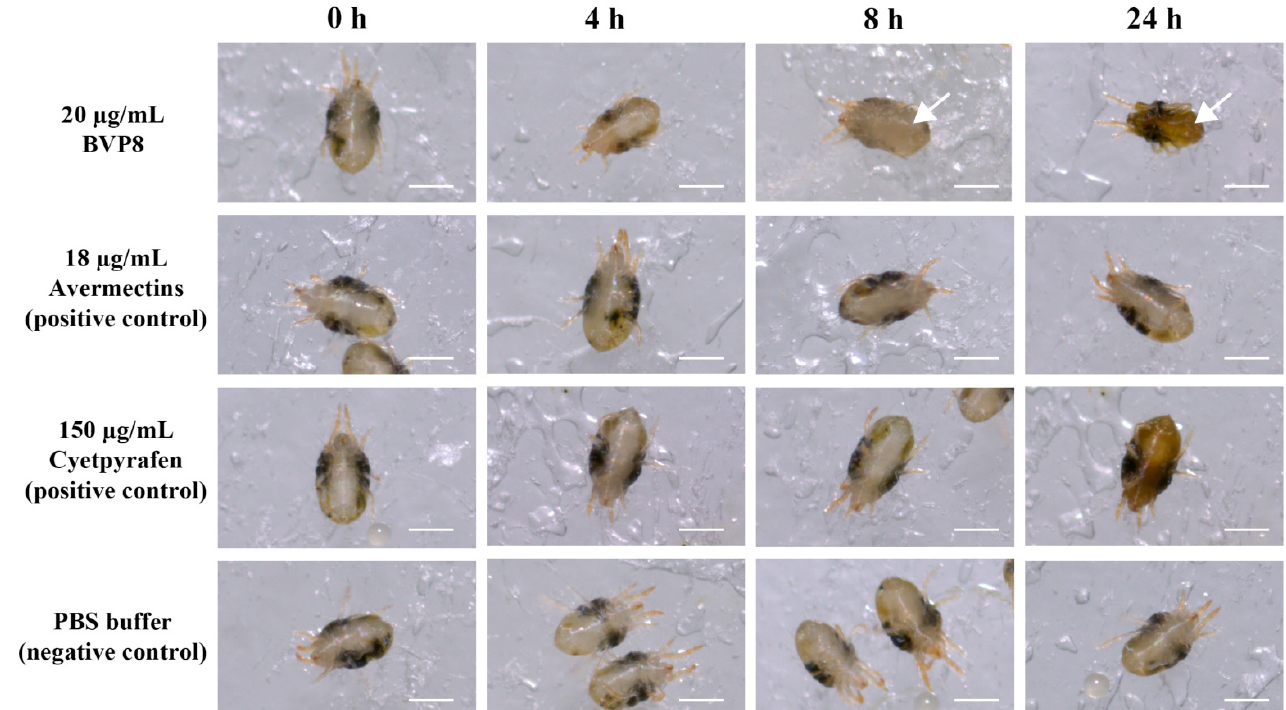
Figure 3. Female adult Tetranychus urticae (green) treated with 20.0 µg/mL purified BVP8 proteins, 18.0 µg/mL avermectins, 150.0 µg/mL cyetpyrafen (positive controls), and phosphate-buffed saline buffer (negative control) for 24 h. Approximately 120 active adult mites were used for each individual treatment. Bars represent 250 µm. Arrows indicate signs of body dehydration.